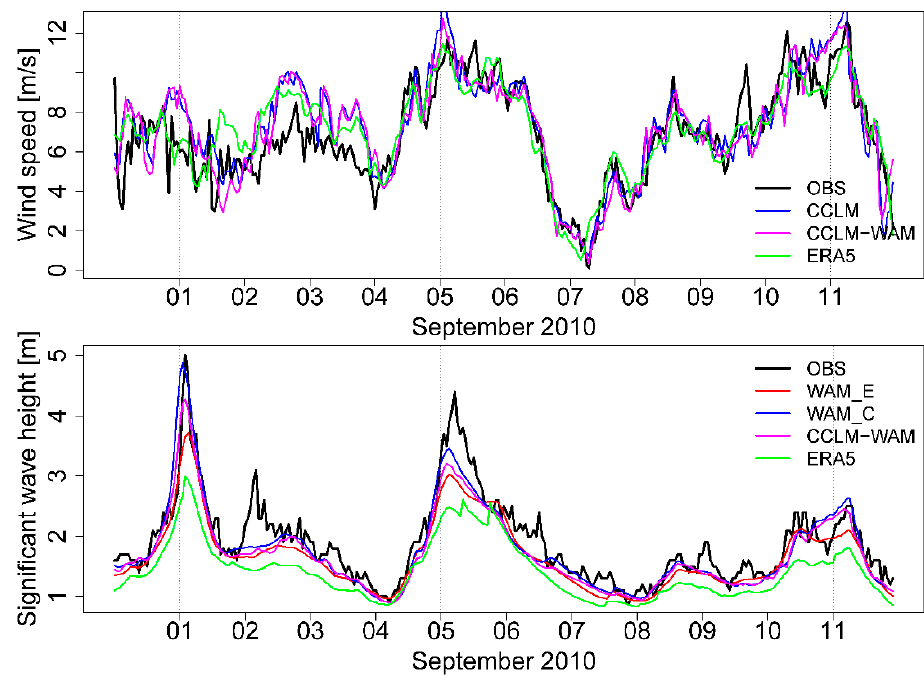
Figure 11. The same as Figure 10 but at station S6.